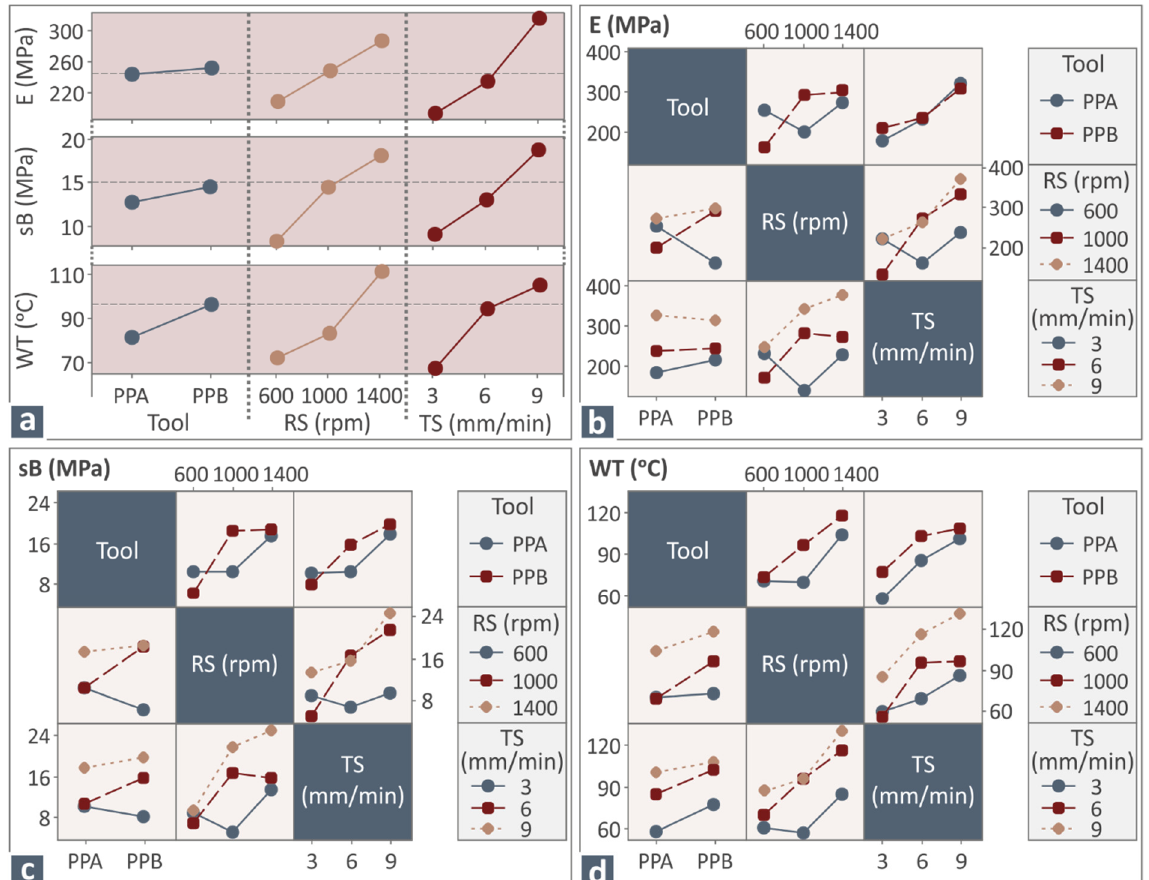
Figure 8. ( a ) MEPs for E, sB, and WT, and ( b – d ) interaction plots between tool, RS, and TS vs. E, sB, and WT.